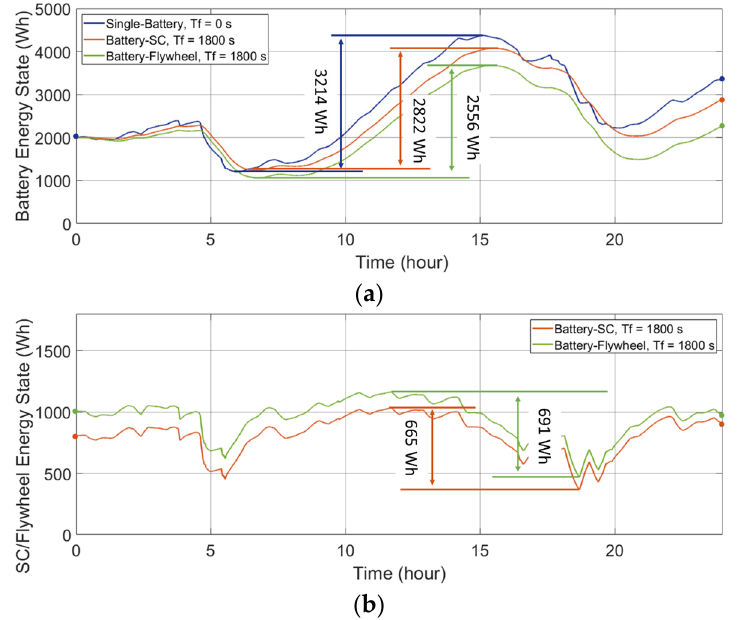
Figure 7. Energy states of the ESDs in the single-battery ESS and the HESSs applied to a wind- powered household-prosumer system. ( a ) Battery energy state. ( b ) SC/flywheel energy state.